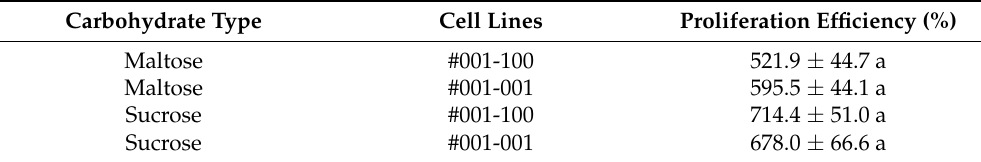
Table 7. E ff ects of maltose and sucrose on EC proliferation e ffi ciency of Korean pine. Table 7. Effects of maltose and sucrose on EC proliferation efficiency of Korean pine. Carbohydrate Type